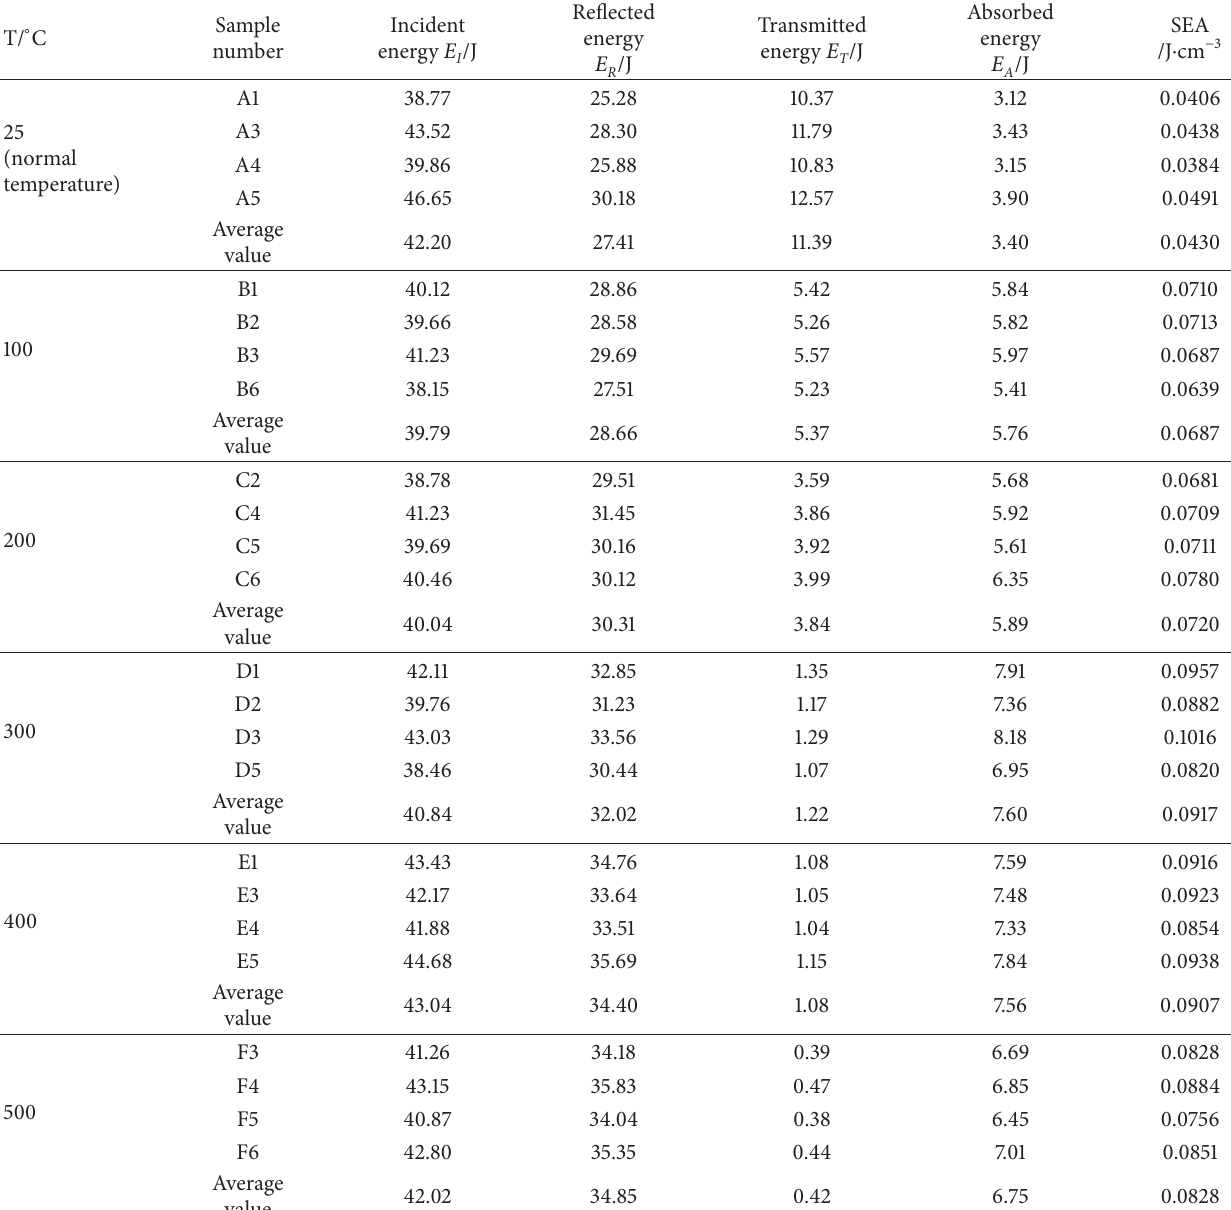
Table 2: The variation of energy with temperature during the experimental